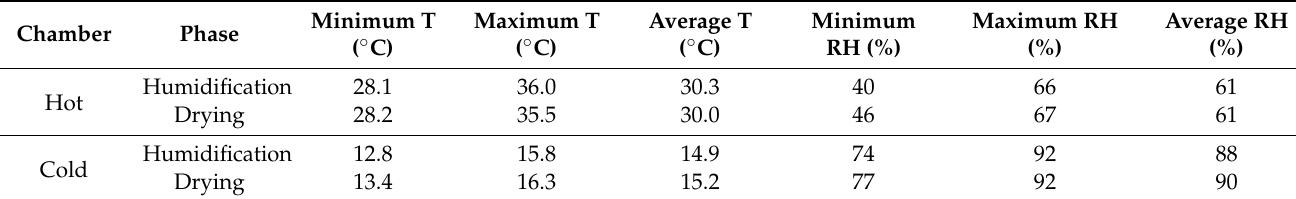
Table 1. Environmental conditions in the hot and cold chambers.